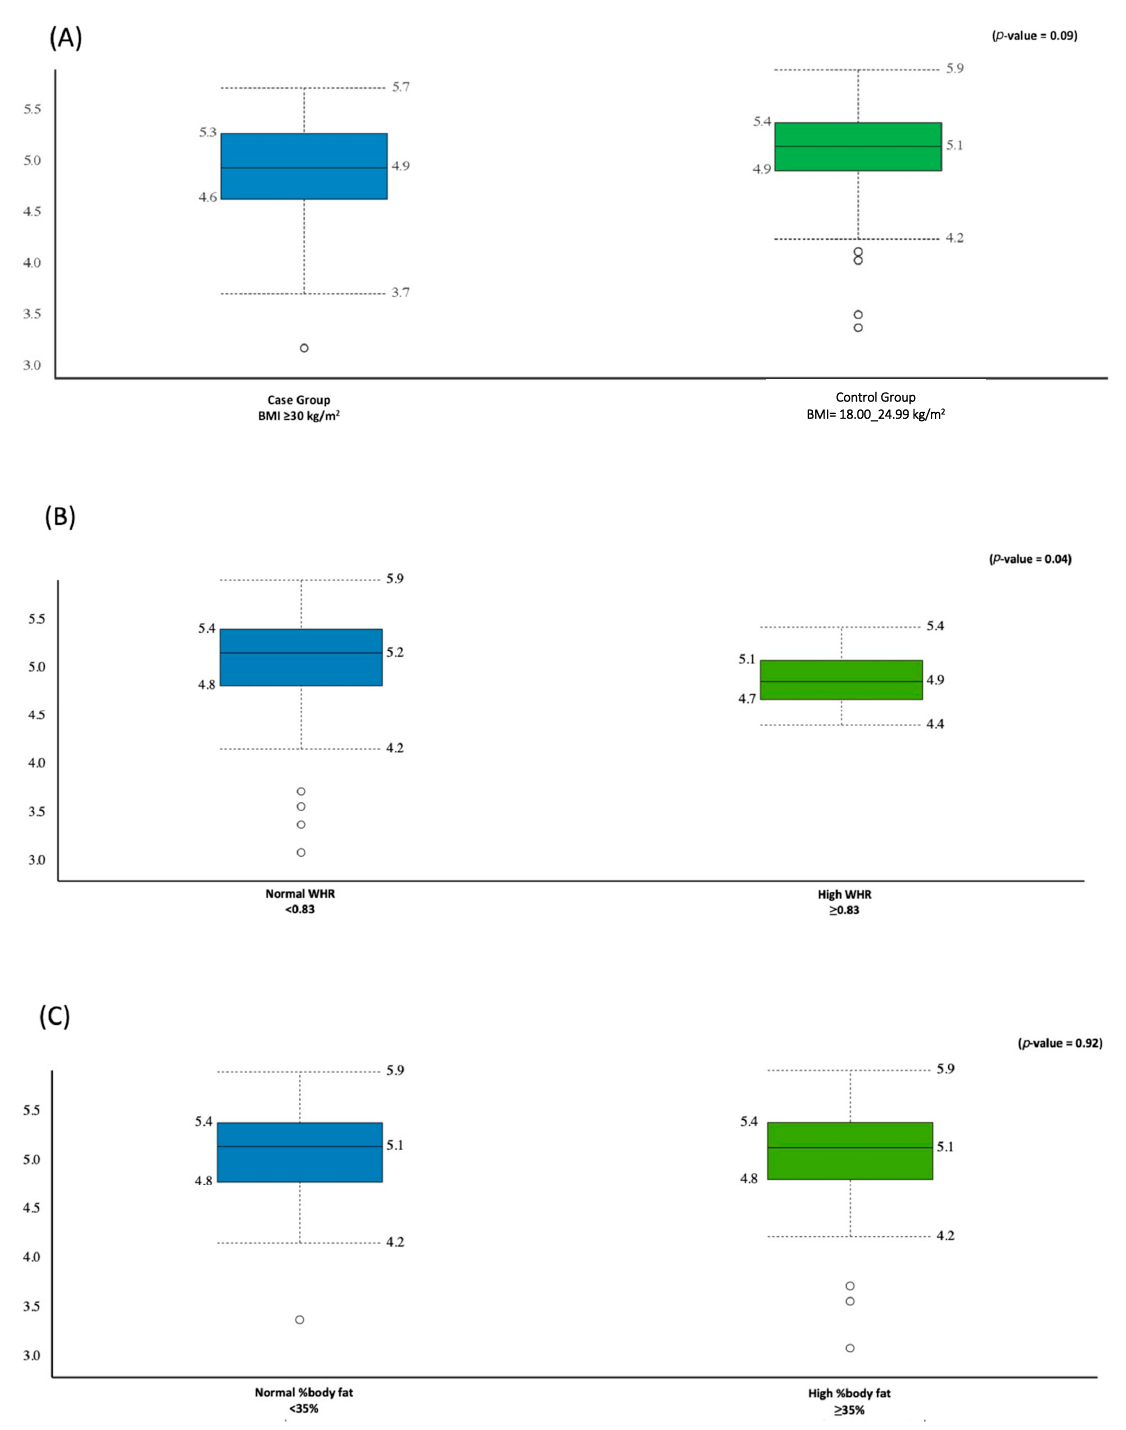
Figure 1. Comparison between the gut microbiota alpha diversity (Shannon–Wiener index) and obesity markers: ( A ) relative to the BMI, ( B ) relative to WHR, ( C ) relative to %body fat.